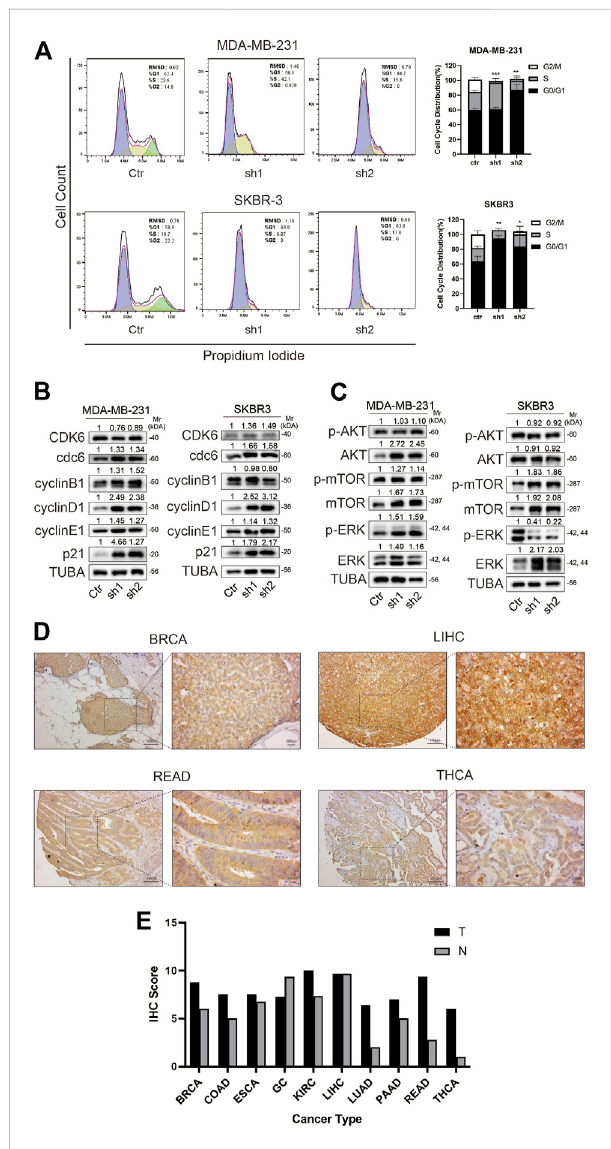
BOLA2B knockdown caused cell cycle arrest and downstream pathway. (A) Flow cytometry of cell cycle and statistical histogram of BOLA2B knockdown in MDA-MB-231 and SKBR3. (B) Western blot of related cell cycle marker in MDA-MB-231 and SKBR3. (C) Western blot of downstream pathway markers in MDA-MB- 231 and SKBR3. (D) Representative images of IHC staining of